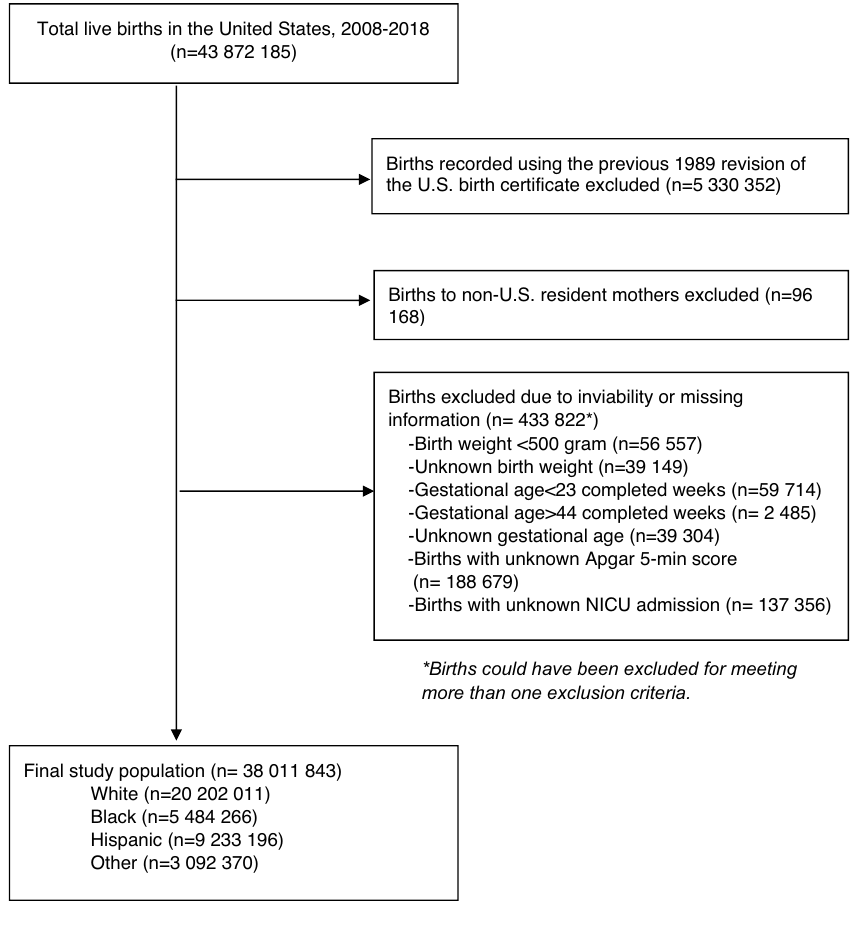
Figure 1. Cohort